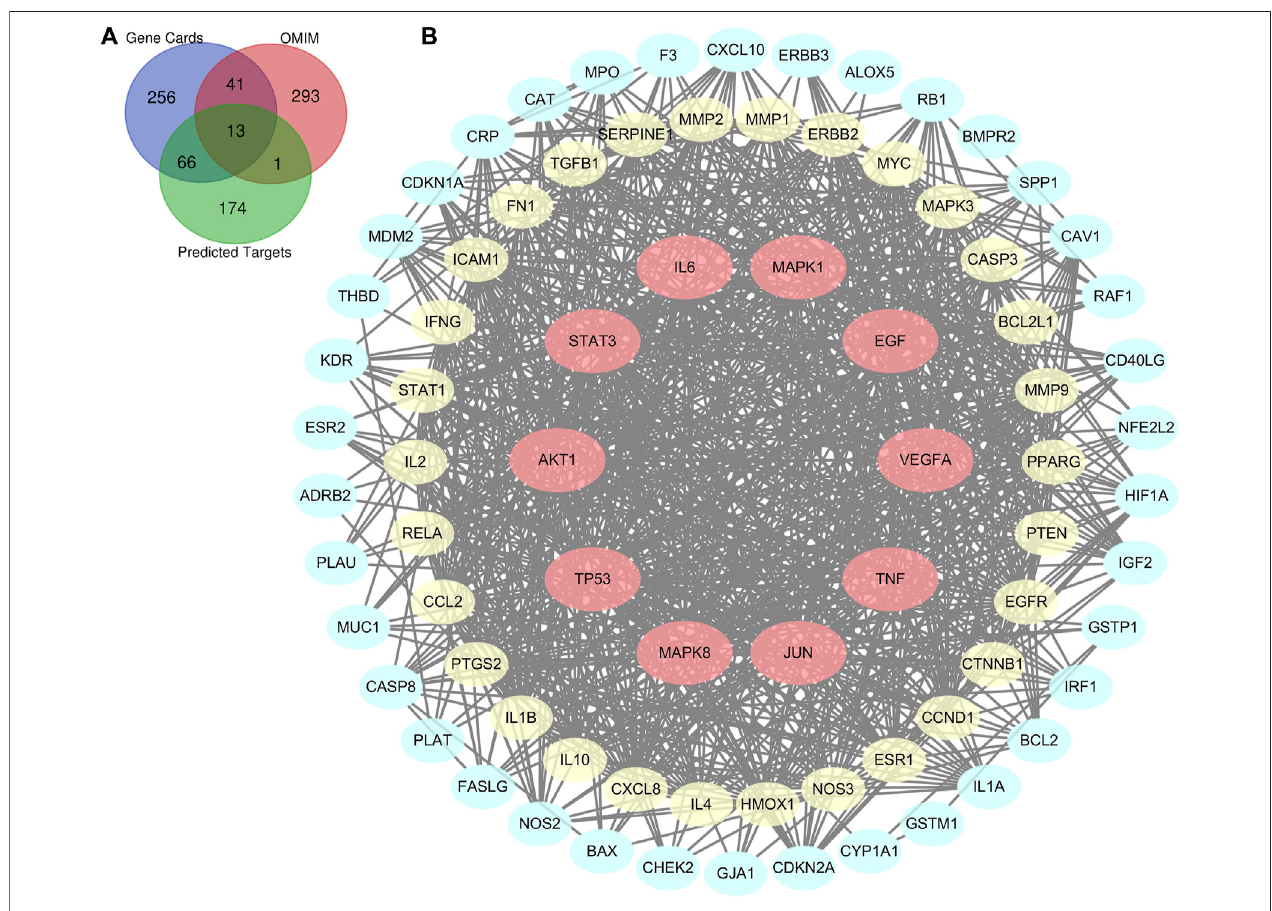
FIGURE1| Bioinformaticsanalysisofoverlappinggenes. (A) 80overlappinggenesbetweenthepredictedtargetsofLHQW(254genes)andthetargetsassociated with ALI in GeneCards (376 genes) and OMIM databases (348 genes). (B) PPI network of the 80 overlapping genes. The importance of each gene was analyzed by STRING.The higher the degree was, themore crucial the gene was. Red nodes representthe major nodes with degree values ≥ 40.The colorsofnodes from reddish to yellowish to blueish are arranged in descending order based on their degree values.